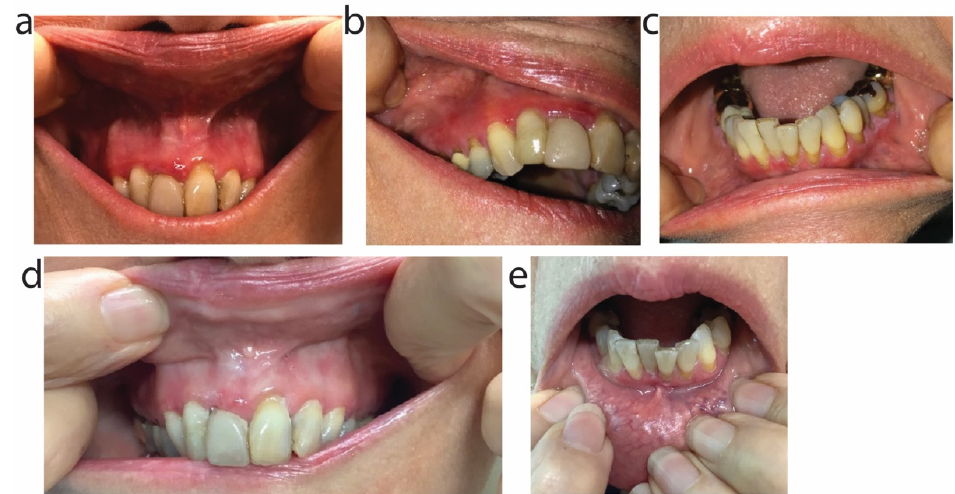
Figure 7. Erosions and inflammation of gingiva due to mucous membrane pemphigoid were reduced and controlled using oral sarecycline. Clinical photos of upper ( a , b ) and lower ( c ) gingiva prior to sarecycline use show red erosions along the central and right upper gingiva and erosions along the central lower gingiva. The clinical findings were associated with elevated antibodies to BP180. ( d , e ) Clinical improvement of the gingiva was observed 38 days later, after the patient completed 38 days of oral sarecycline 60 mg daily.